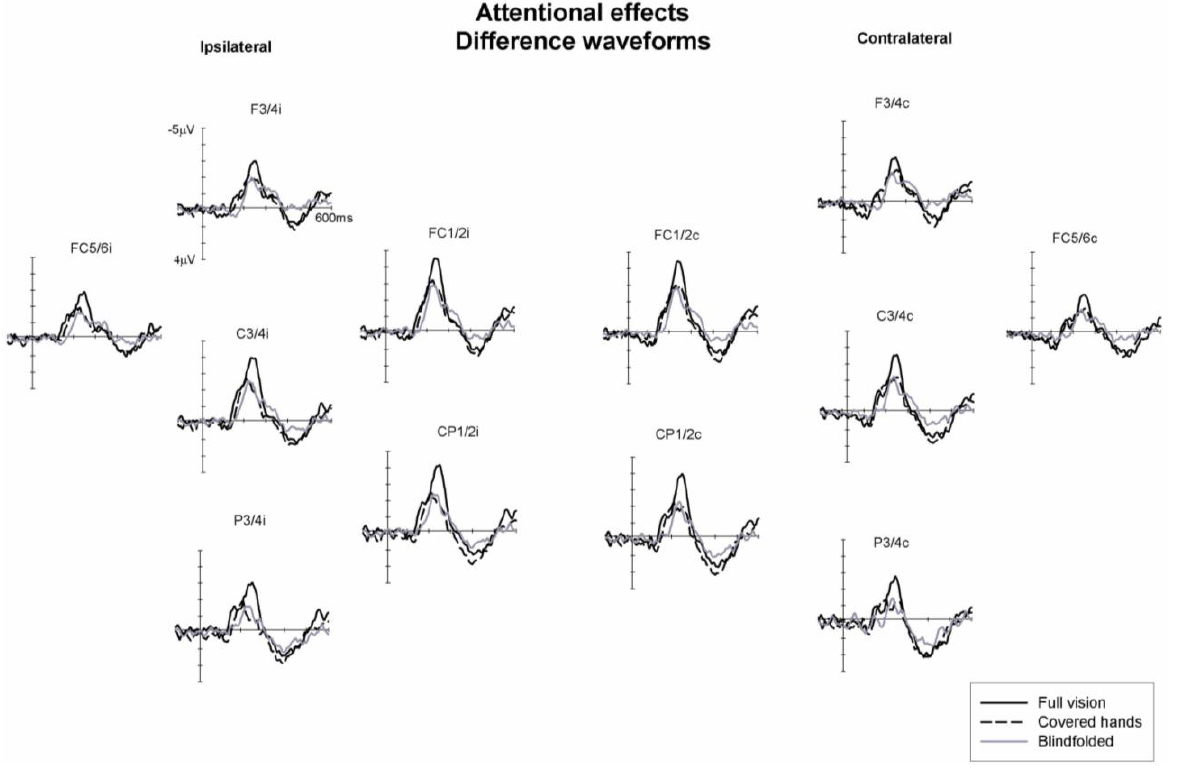
FIGURE 2. Visual modulation ofeffects of sustained spatial attention on tactile processing.The figure shows difference ERP waveforms obtained by subtracting ERPs in response to tactile (mechanical) stimuli at attended and unattended locations during the 600-msec interval following stimulus onset, in the conditions “full vision” ( black solid lines ), “covered hands” ( black dashed lines ), and “blindfolded” ( grey solid lines ). The distance from the x axis represents the amplitude of the attentional effects (i.e.,“attended” minus “unattended” ERPs) in each condition. Difference waveforms are shown for electrodes contralateral (right side of the panel) and ipsilateral (left side) to the site of tactile stimulation. In the “full vision” condition,attentional effects were present earlier than in the “covered hands” and “blindfolded” conditions and were more enhanced. See text for further details. (Data from Sambo et